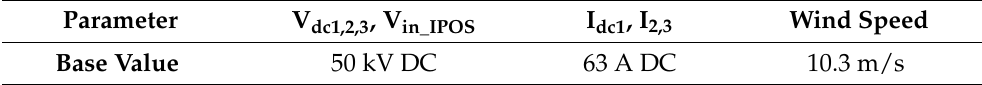
Table 1. Base V=value of terminal voltages and cable currents in